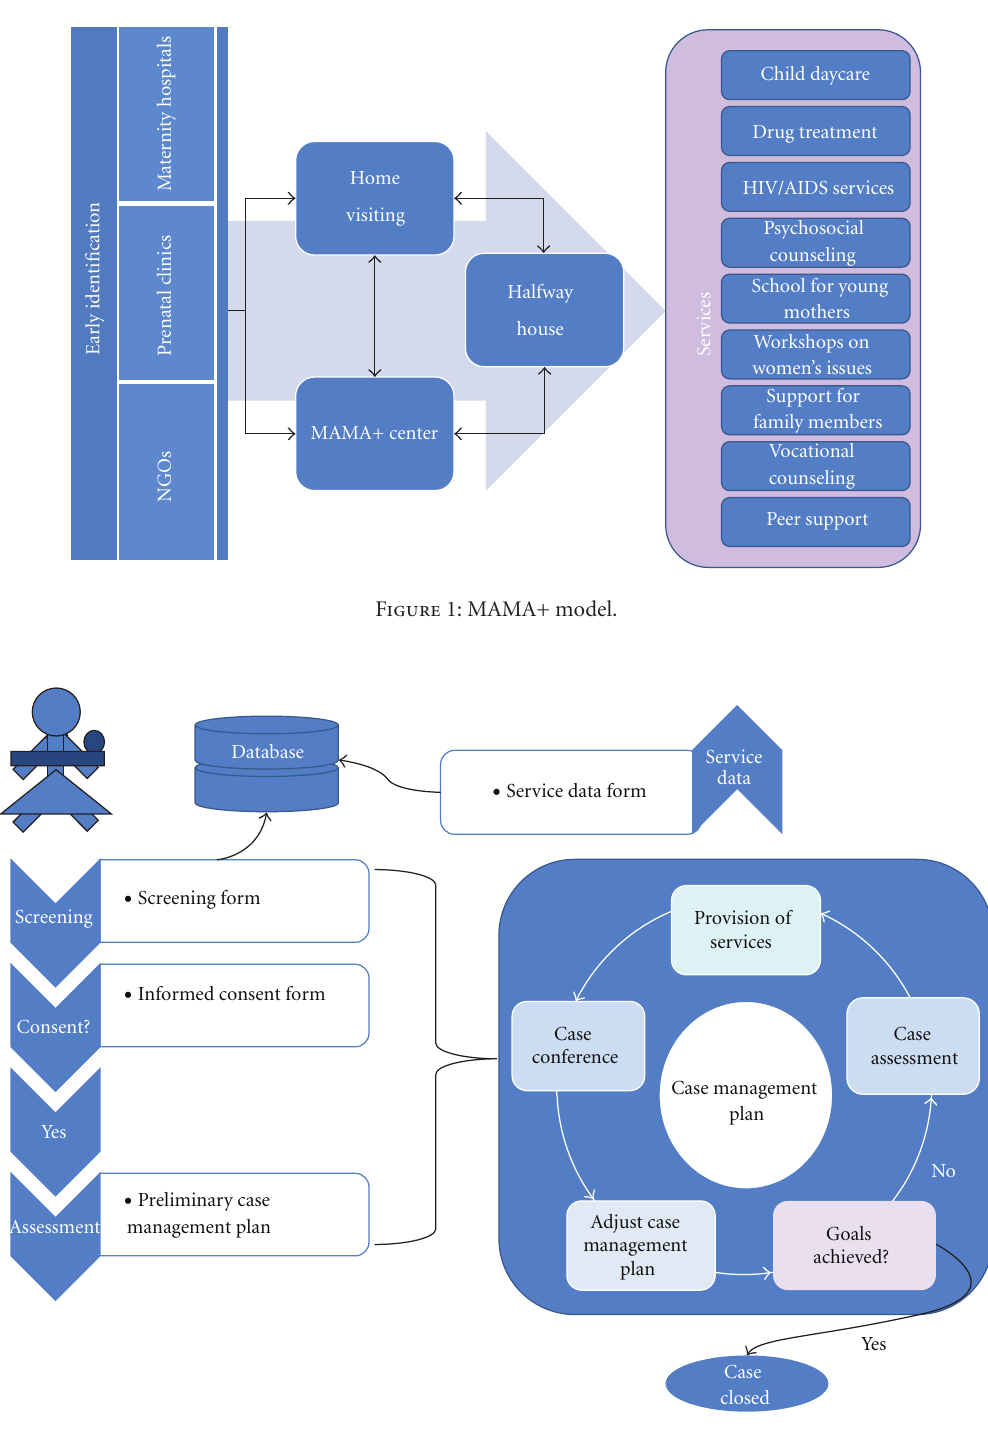
Figure 2: Case management